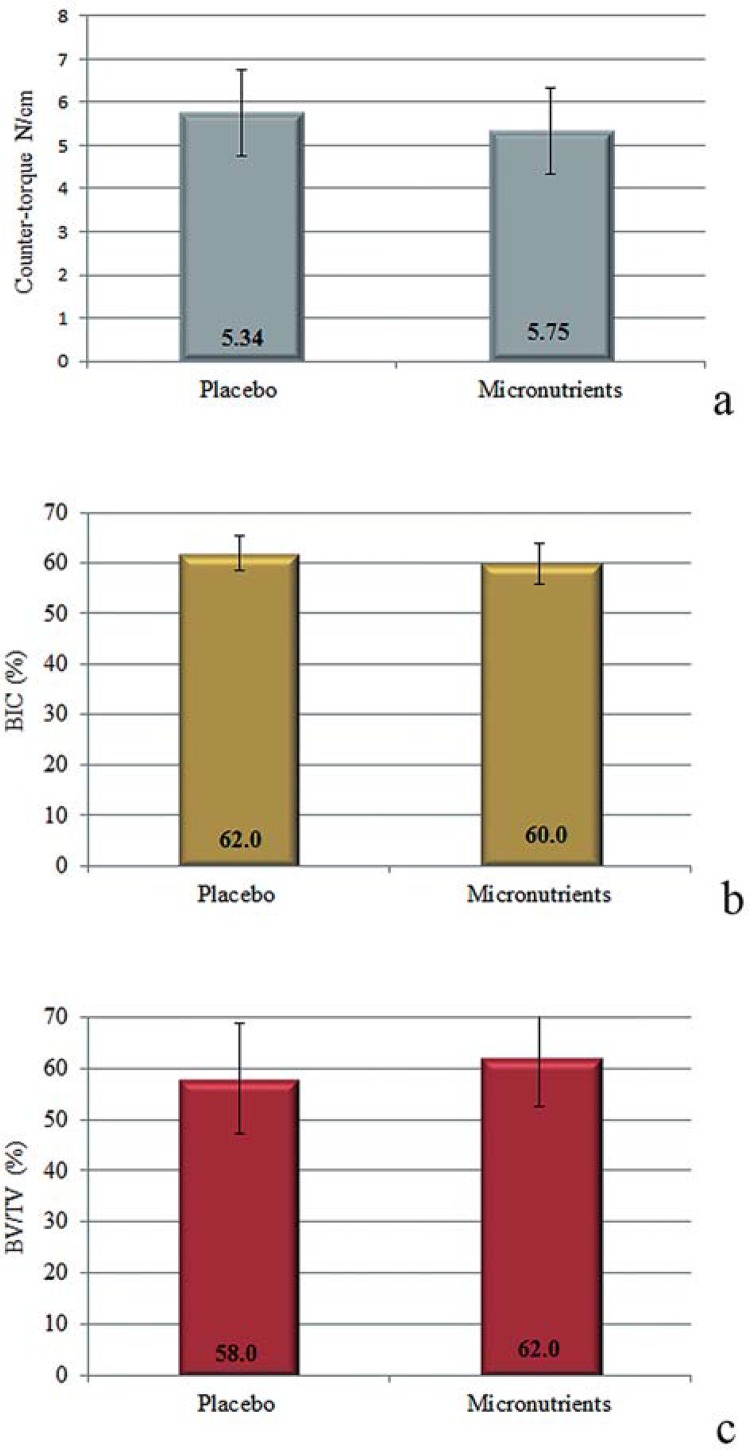
 a) Graphic illustrating means and standard deviations of counter-torque values (N/cm) in both groups; b and c) Mean percentage and standard deviations of BIC (b) and BV/TV (c) in Placebo and Micronutrients groups. No significant differences between groups were observed for counter-torque and microCT analysis (p>0.05)